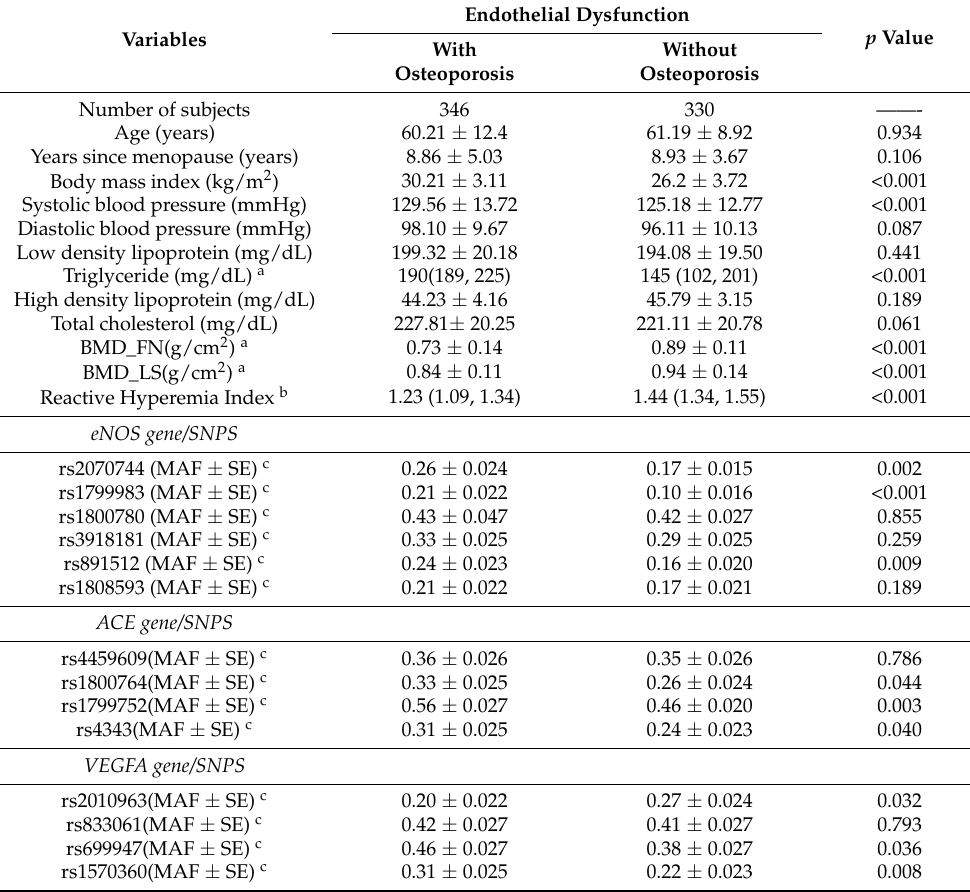
Table 1. Variables at baseline according to osteoporosis status in postmenopausal women having endothelial